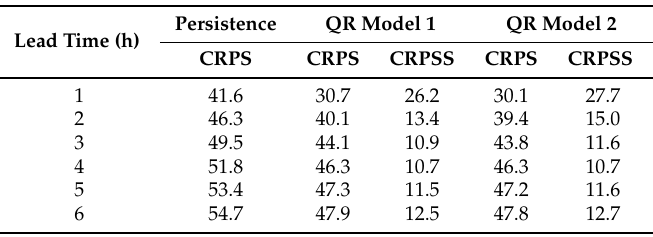
Table 3. CRPS and CRPS skill score (CRPSS) for the site of Desert Rock. CRPS values are in W · m − 2 , and the CRPSS is in